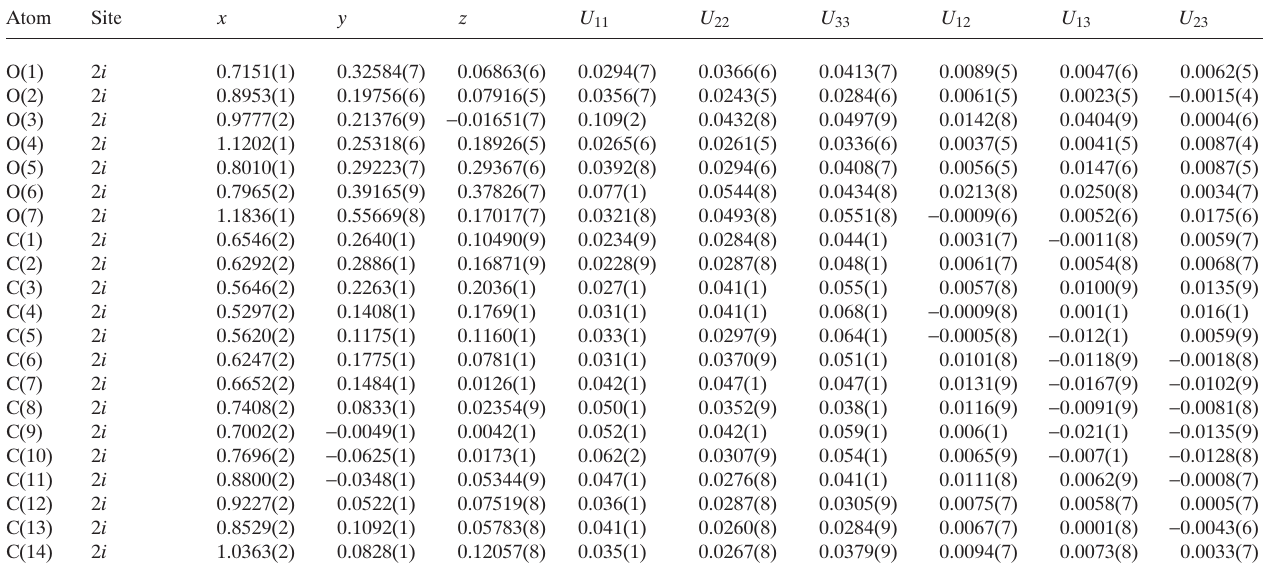
Table 3. Atomic coordinates and displacement parameters (in Å 2 ) .